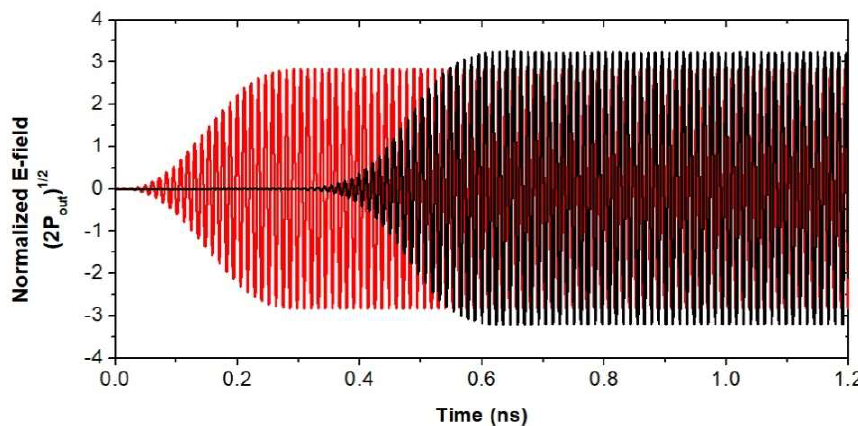
Figure 20. Input (red) and output (black) power of the modulation section at 86.5 GHz.